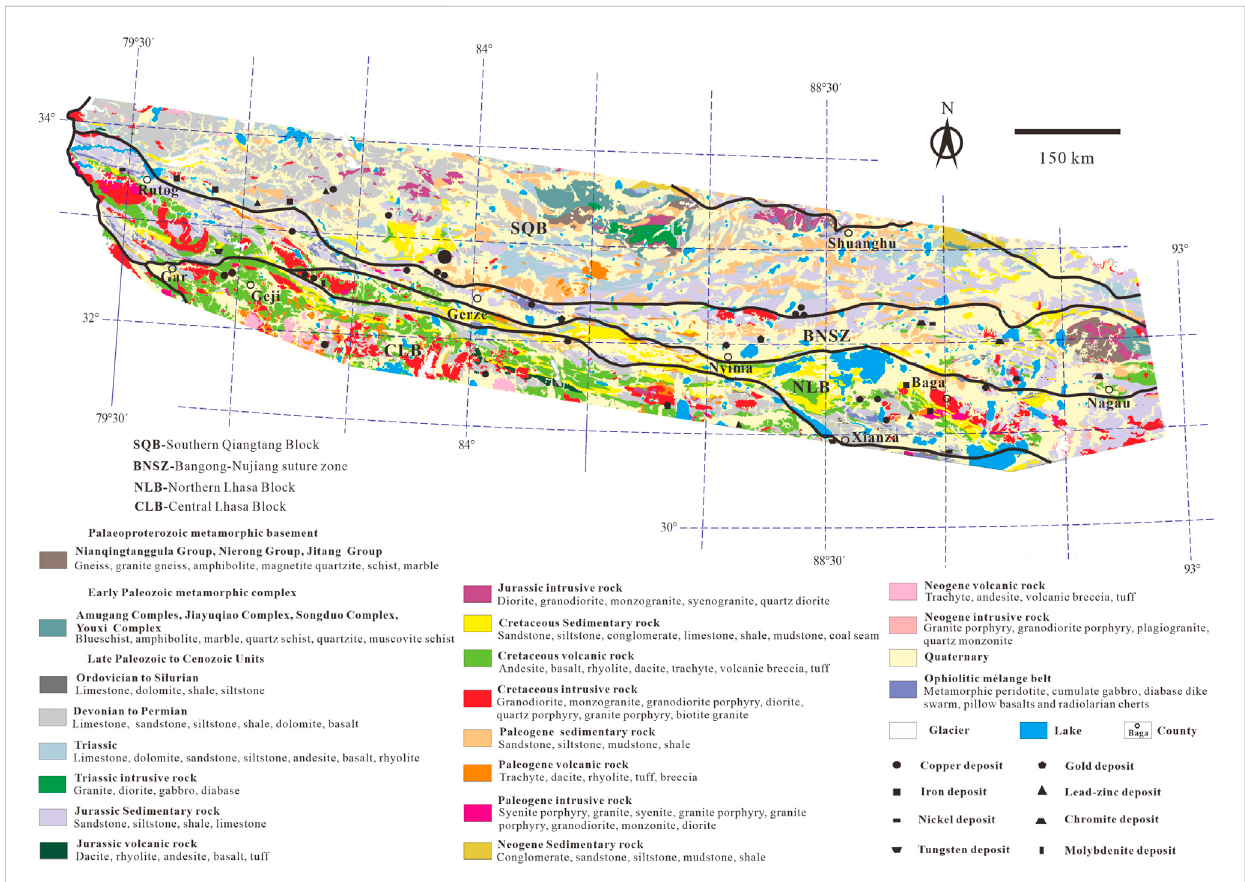
FIGURE 2 Geology of the Bangong – Nujiang metallogenic